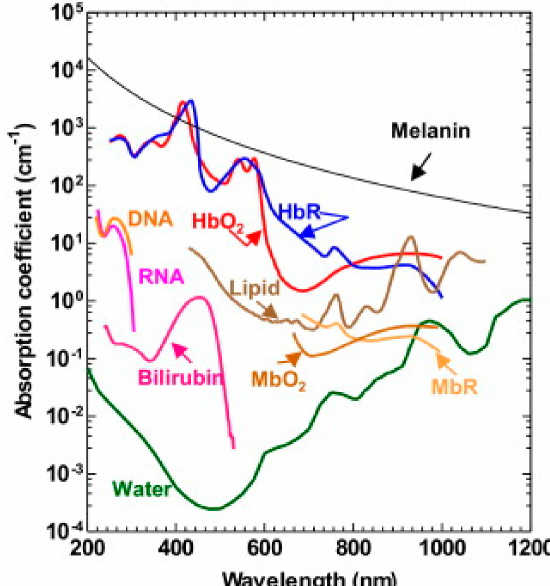
Figure 1. Absorption spectrum of major contrast agents in biological tissue from 200 to 1200 nm in wavelength, including melanin, oxyhemoglobin (HbO 2 ), deoxyhemoglobin (HbR), DNA and RNA, lipid, bilirubin, oxy-myoglobin (MbO 2 ), reduced myoglobin (MbR), and water. Reprinted with permission from